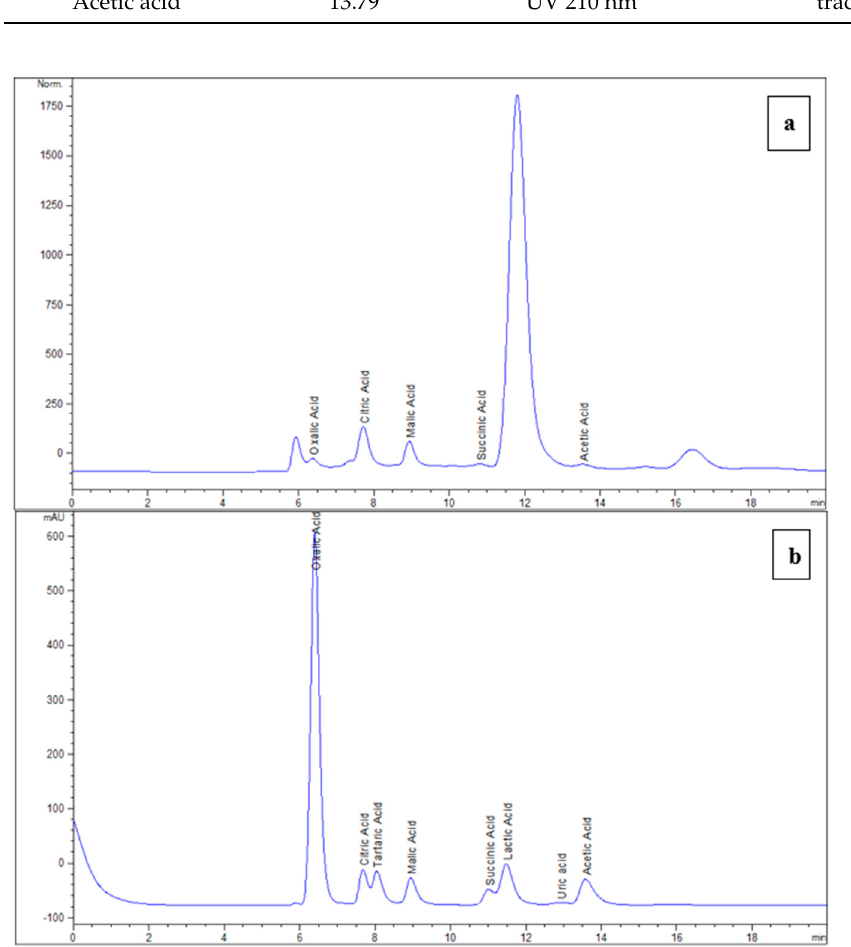
Figure 1. ( a ) HPLC chromatogram for organic acids of cladode juice (15% v/v ) at 210 nm; ( b ) HPLC chromatogram of organic acid standards mix.